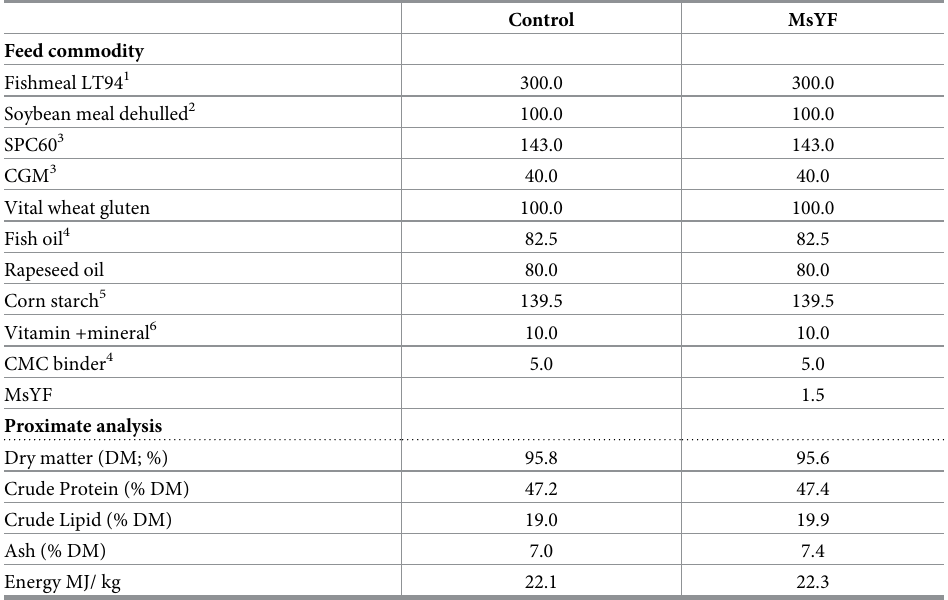
Table 1. Formulation (g/kg) and proximate composition of experimental